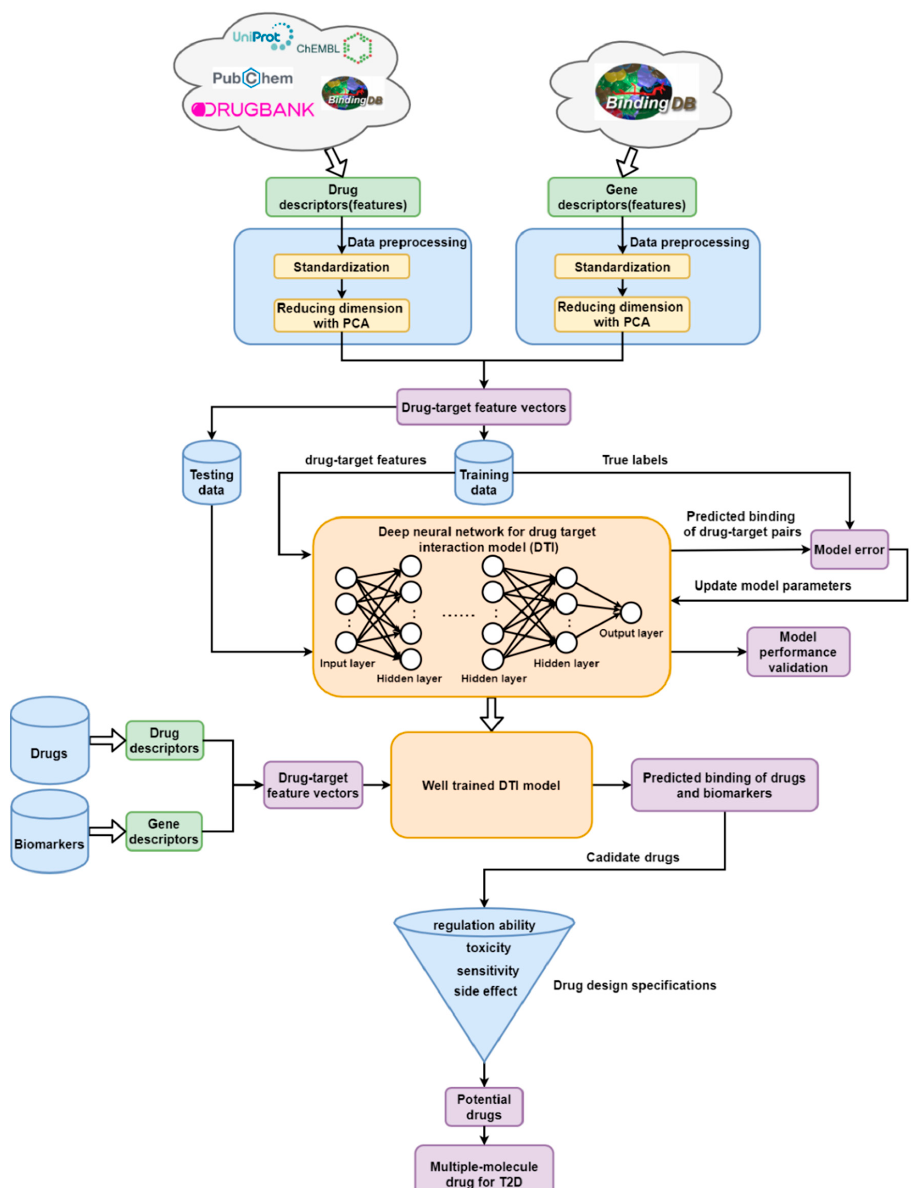
Figure 3. The flowchart of systematic drug discovery and design procedure. The drug–target binding datasets were obtained from BindingDB, which integrated substantial information of drugs and targets from several databases. Then, the drug and target features were sequentially preprocessed through descriptor transformation, standardization, and PCA dimension reduction. Afterwards, the processed data were split into training and testing data for deep neural network (DNN)-based drug–target interaction (DTI) model training and performance evaluation, respectively. During the training process, the model parameters were updated through the error between the true binding label and predicted binding label of each drug–target pair. The well-trained DNN-based DTI model was used to predict the binding probability between drugs and the identified biomarkers to sift out candidate drugs. Finally, with the consideration of drug design specifications including regulation ability, toxicity, sensitivity, and side effect, potential drugs were selected and integrated for novel medication therapy curing T2D.